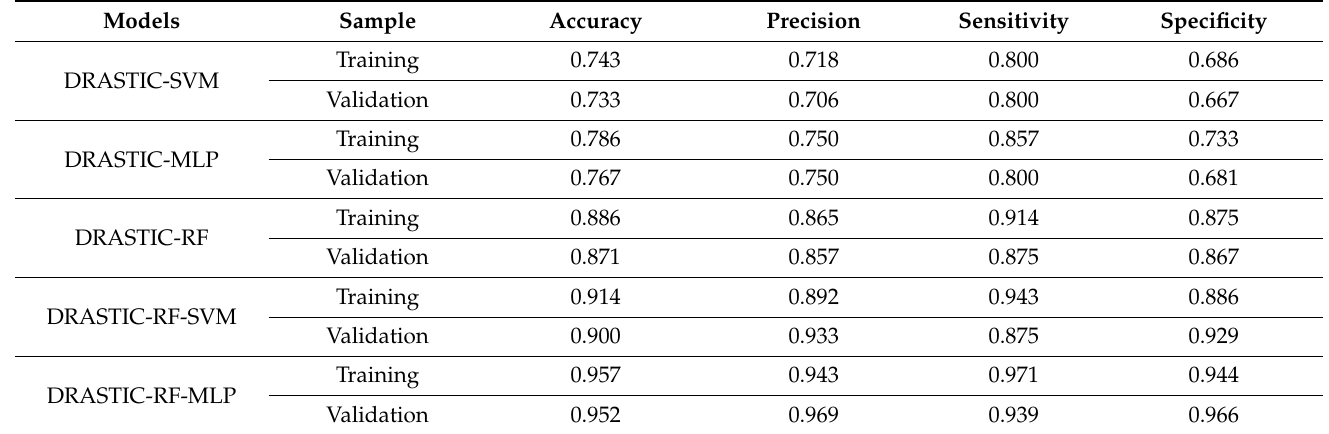
Table 2. Model statistical measures assigned to training and validation